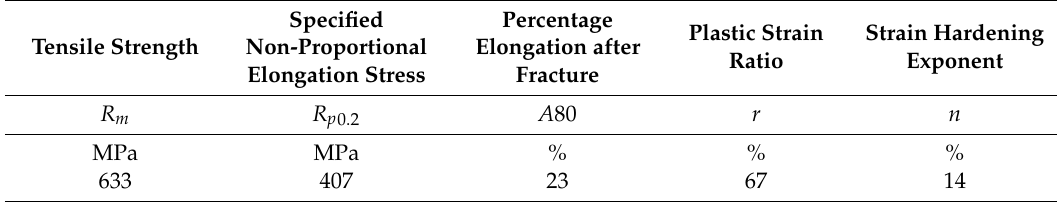
Table 1. Mechanical properties of DP600 steel.